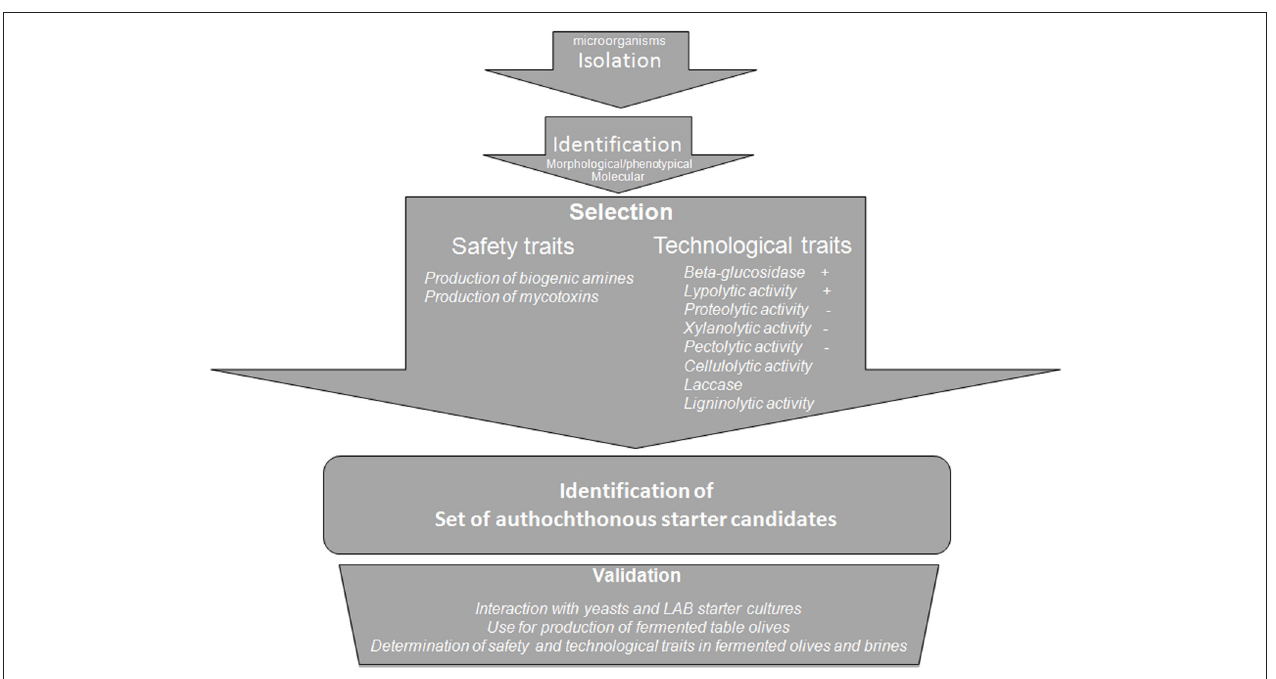
FIGURE 2 | Flow-sheet for the selection of a mold starter culture.